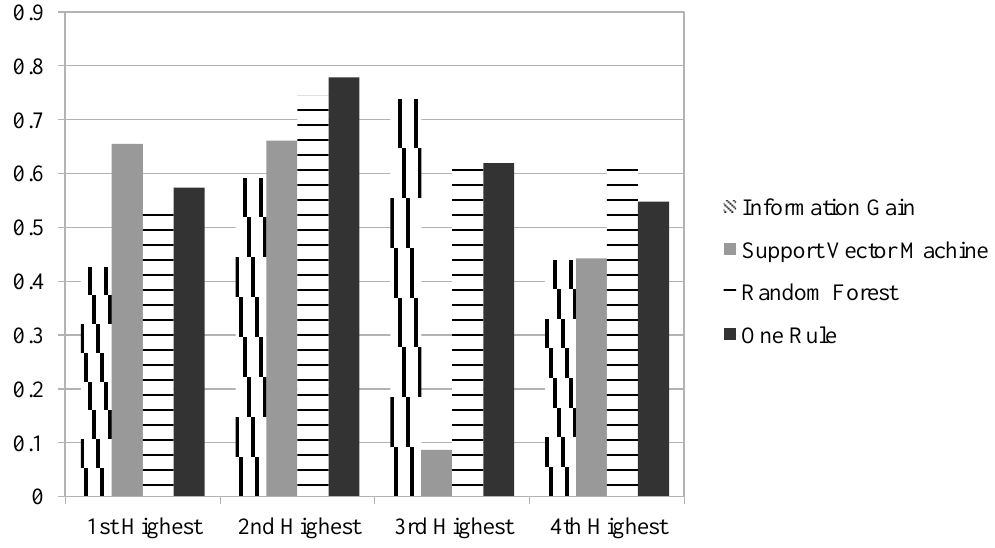
Figure 3. R 2 Between PCA and capital city distances for subsets of ranked